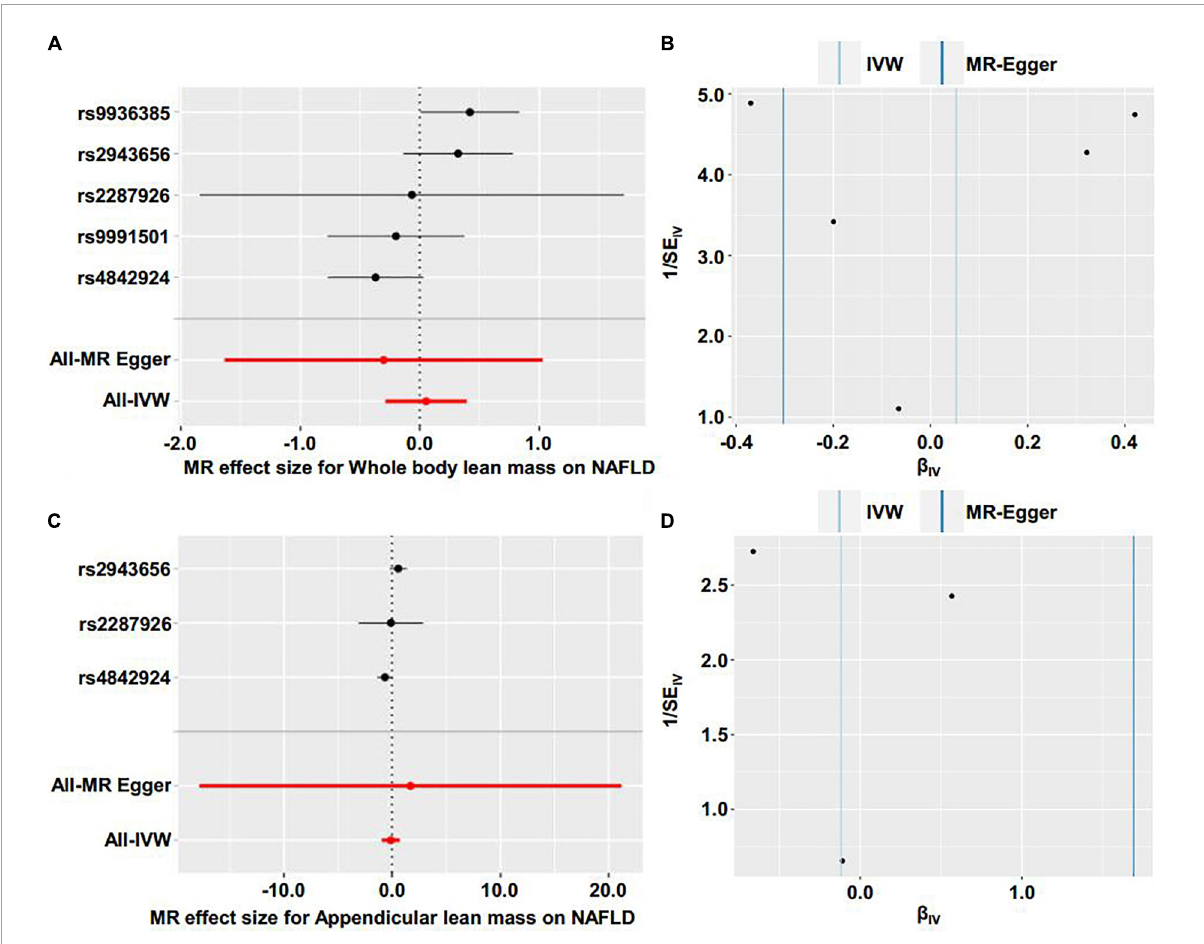
FIGURE3 Forest plot and funnel plot of the causal effect of lean body mass on NAFLD. (A) Forest plot of the causal effect of whole body lean mass on NAFLD. (B) Funnel plot of the causal effect of whole body lean mass on NAFLD. (C) Forest plot of the causal effect of appendicular lean mass on NAFLD. (D) Funnel plot of the causal effect of appendicular lean mass on